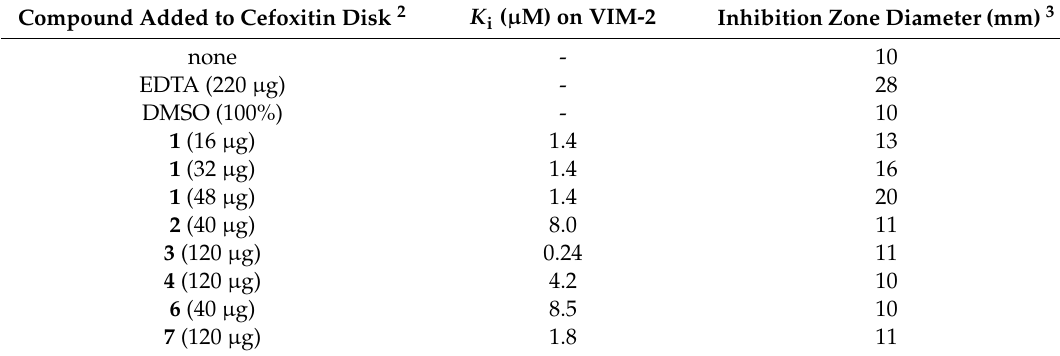
Table 4. In vitro activity of selected VIM-2 inhibitors measured by disk di ff usion on E.